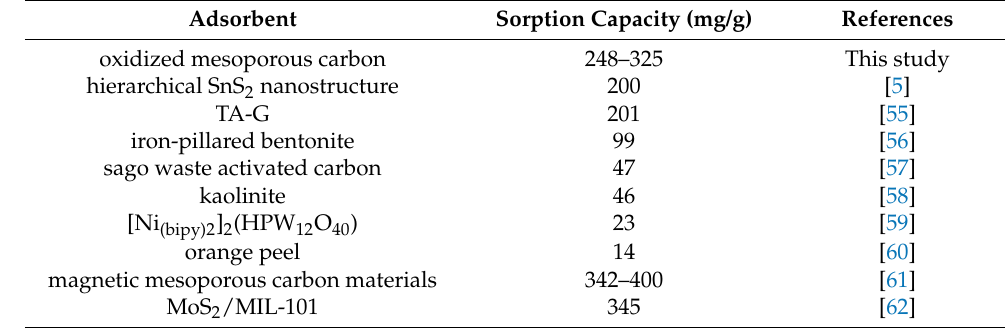
Table 7. Comparison of sorption capacities of oxidized mesoporous carbons with other adsorbents presented in